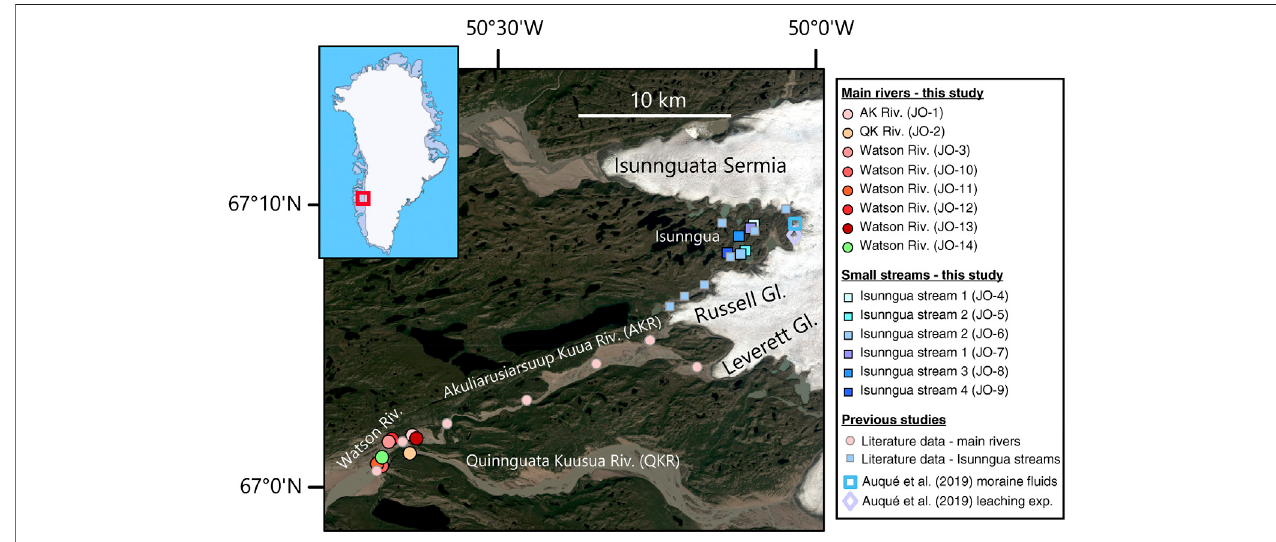
FIGURE1| Satelliteimage(Landsat8)showingtheriversamplelocationsinwestGreenland,collectedaspartofthisstudy,aswellasthelocationsofsamplesfrom previous studies whose data is compiled here for comparison. Inset shows the study region location within Greenland.